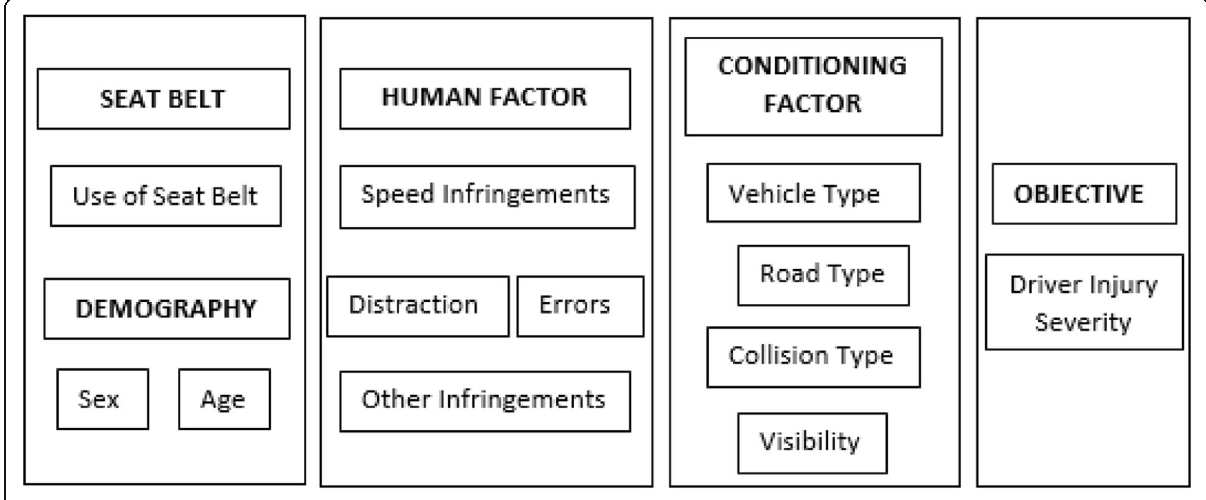
Fig. 2 Factors used in discretization